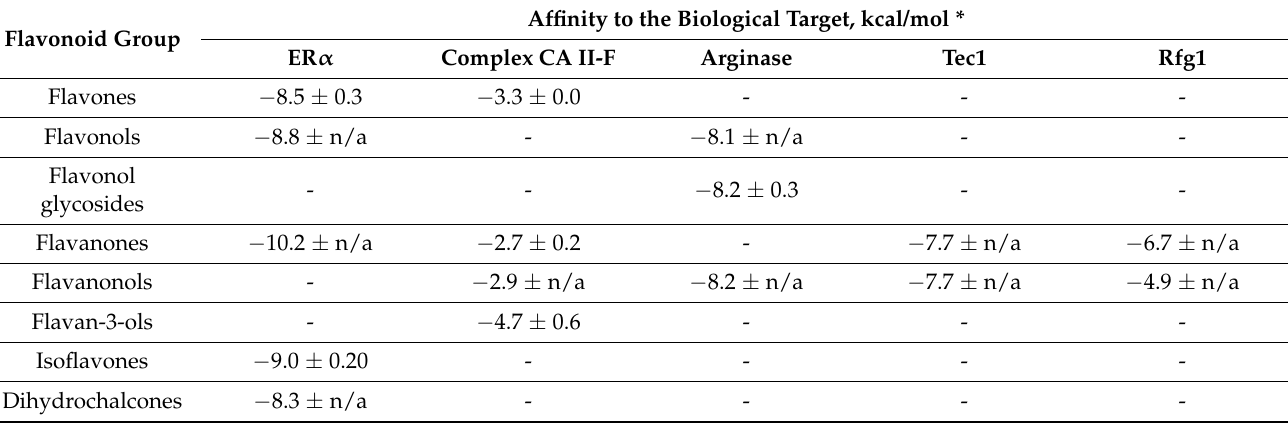
Table 4. Comparison of the average affinity of flavonoid groups to target proteins in